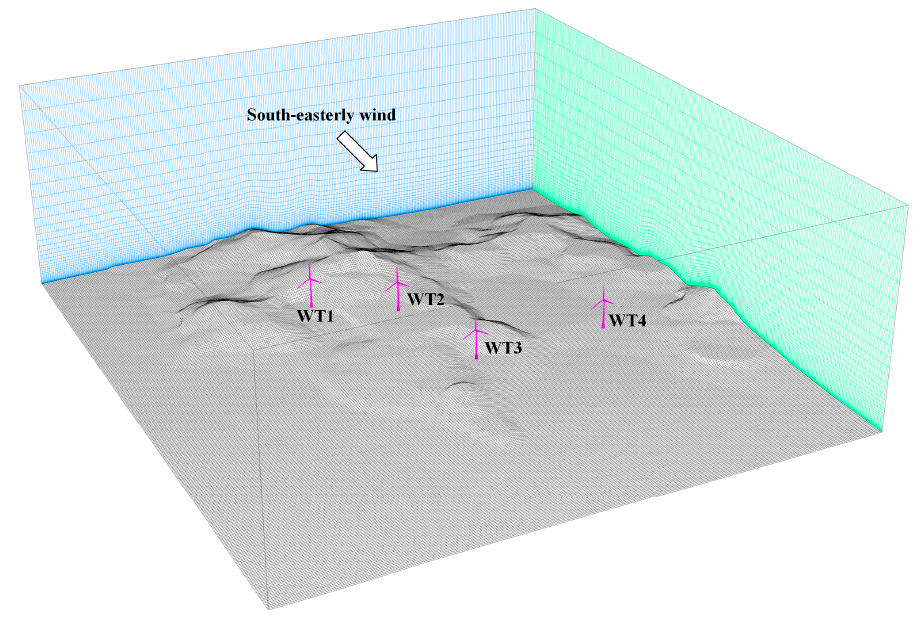
Figure 5. Computational grid cells.